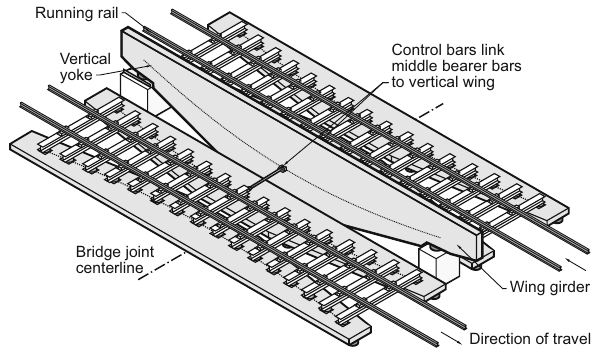
Fig. 12 Combined horizontal and vertical CESuRa